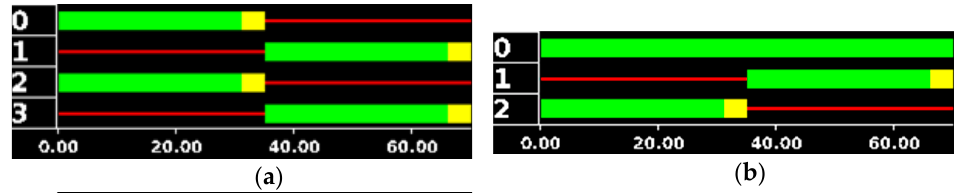
Figure 5. Initial timing of J3 ( a ), initial timing of J1, J2 and J4 ( b ).